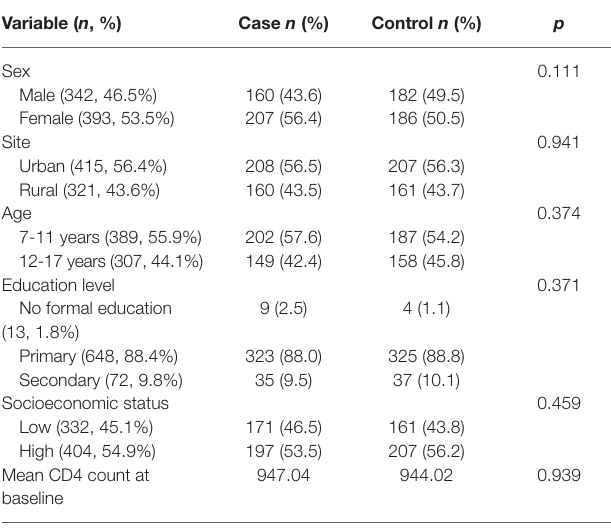
TABLE 1 | Distribution of socio-demographic factors in cases and